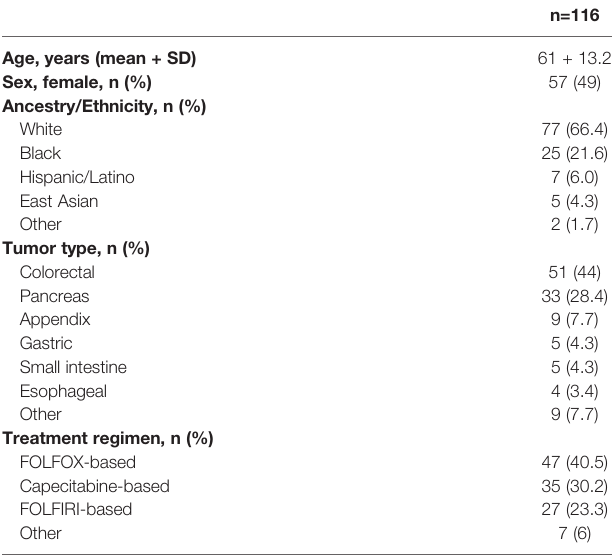
TABLE 4 | Baseline characteristics of the fi rst 116